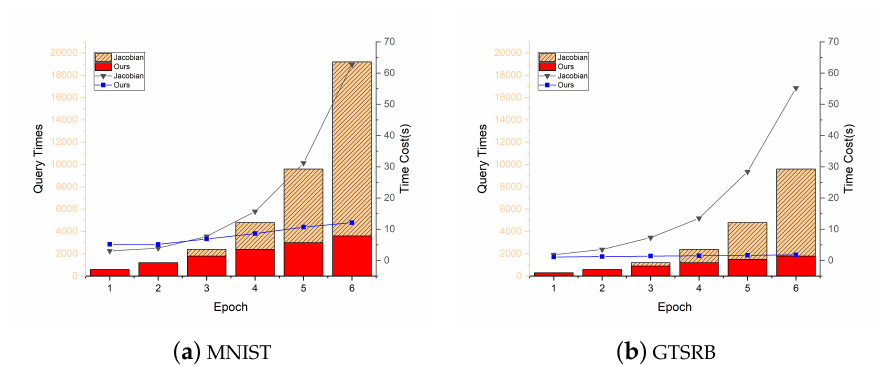
Figure 3. Increase of query times and time cost with the substitute epoch. The column bars indicate the query times and the lines with symbols describe the time cost of each epoch.